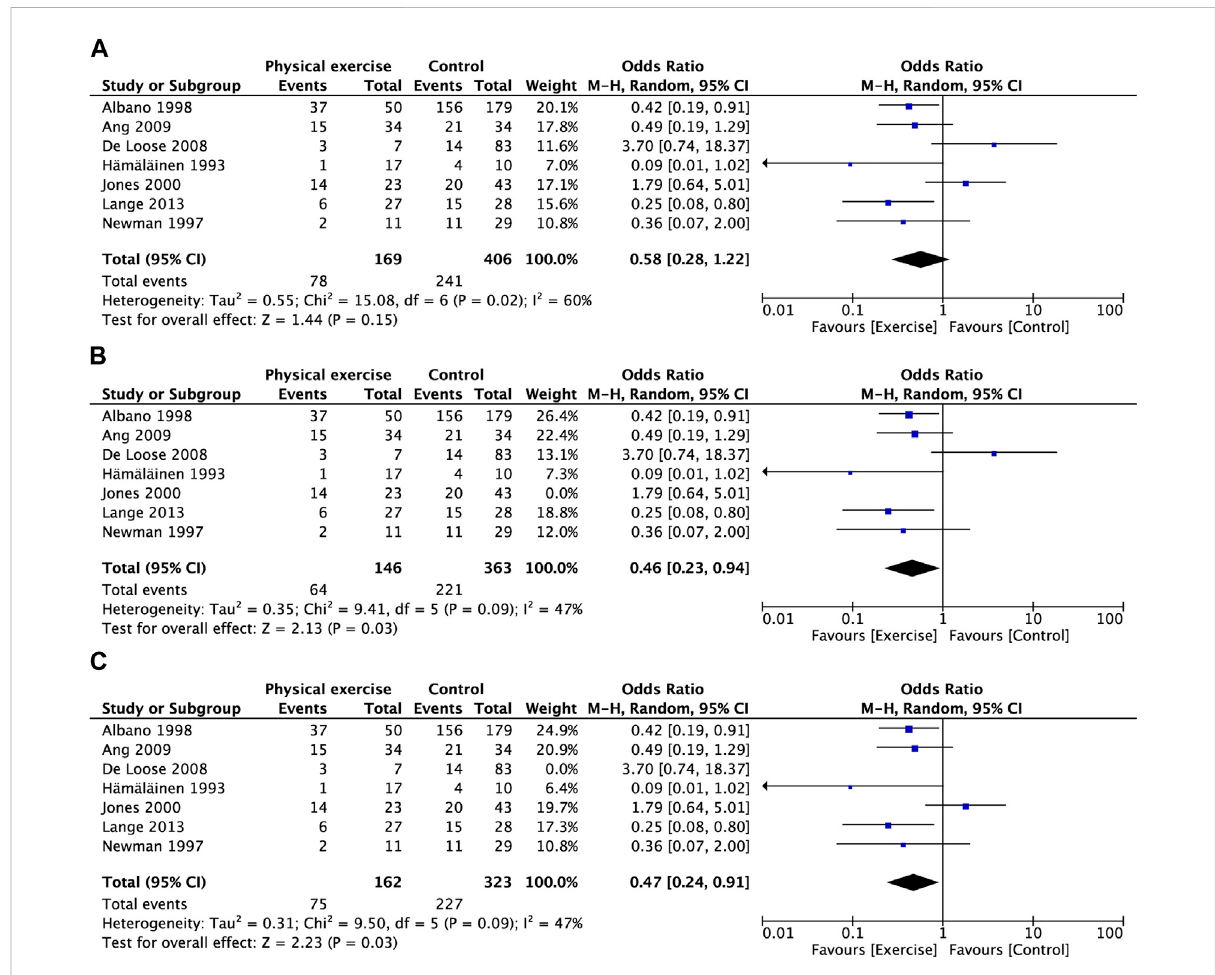
FIGURE 3 Forest plot comparing the prevalence of neck pain in the physical exercise and control groups. (A) Before leave-one-out sensitivity analysis (B) After leave-one-out sensitivity analysis (Jones et al., 2000). (C) After leave-one-out sensitivity analysis (De Loose et al.,